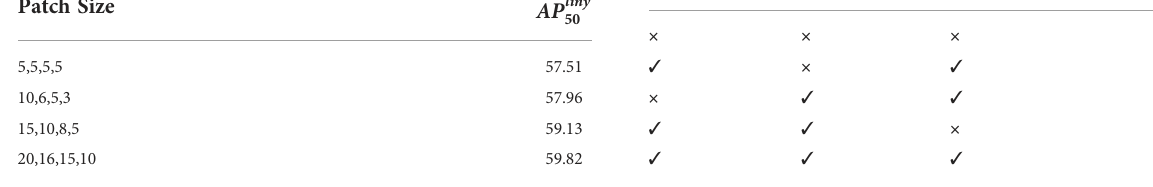
TABLE 2 Ablation study on patch size.